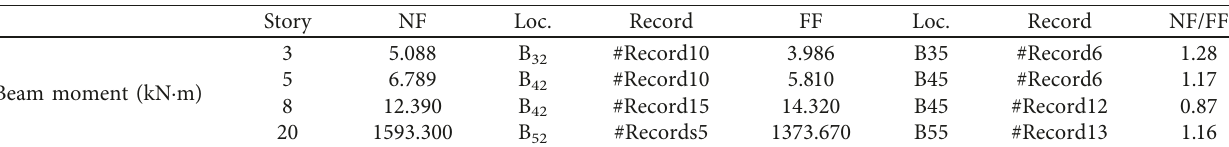
Table 8: Comparison of beam moment in 3-, 5-, 8-, and 20-story buildings subjected to near- and far-field earthquakes.